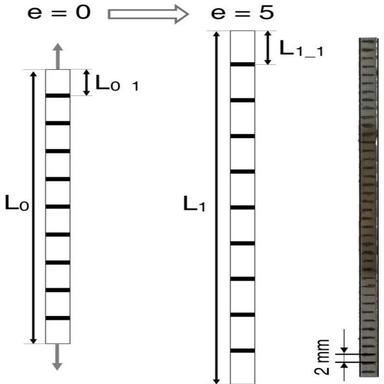
Schematic for local strain measurements.